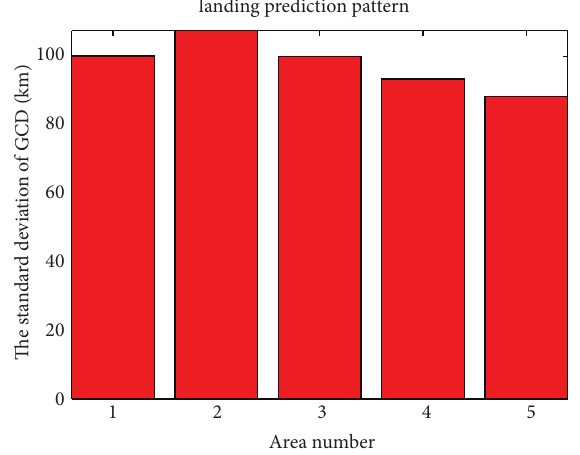
Figure 11: The OPs of historical landing TCs’ centers when they firstly entered into area 1 (LP: landing position).